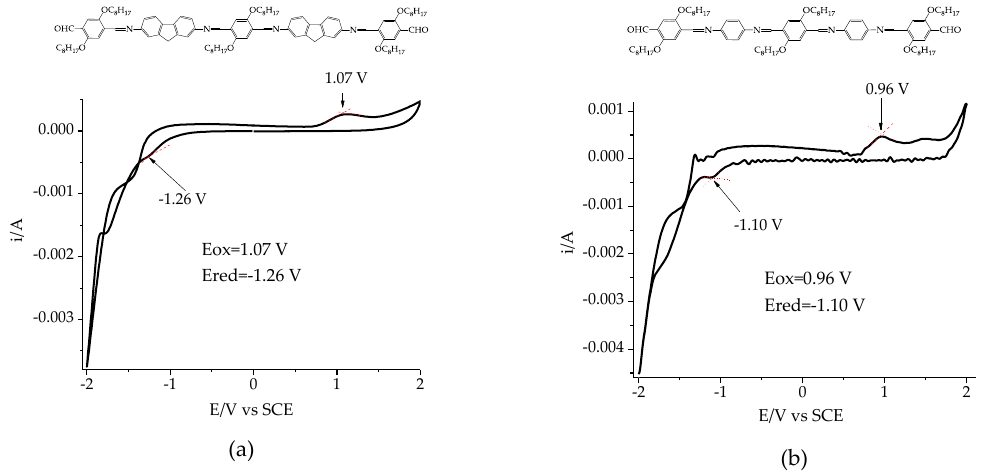
Figure 6. Voltammograms: ( a ) DAFCHO and ( b ) FDACHO, in the BU 4 NPF 6 /Acetonitrile system; 0.1 M, v = 50 mV/s. Table 2. Electrochemical data from DAFCHO and FDACHO.